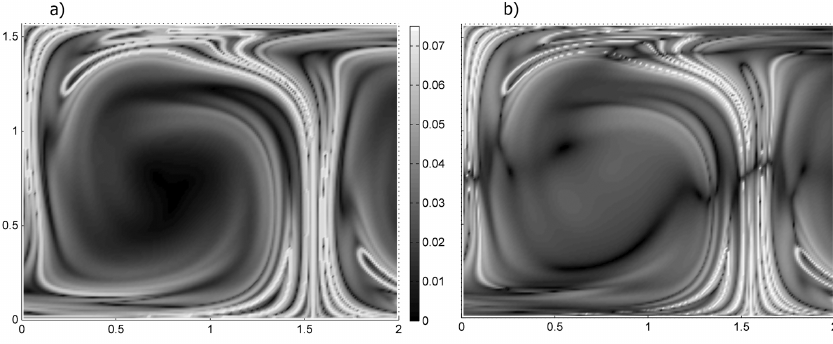
Figure 4. Forward FTLE field of an aperiodic Rayleigh–Bénard convection model. (a) The benchmark FTLE field at t 0 = 1 calculated by Eq. (6). (b) The approximated FTLE field calculated by Eq. (8), and δt = 0.1 time units. A fourth-order Runge–Kutta integration scheme with constant integration time step 0.01 and total integration time T = 75 units is implemented for both panels.